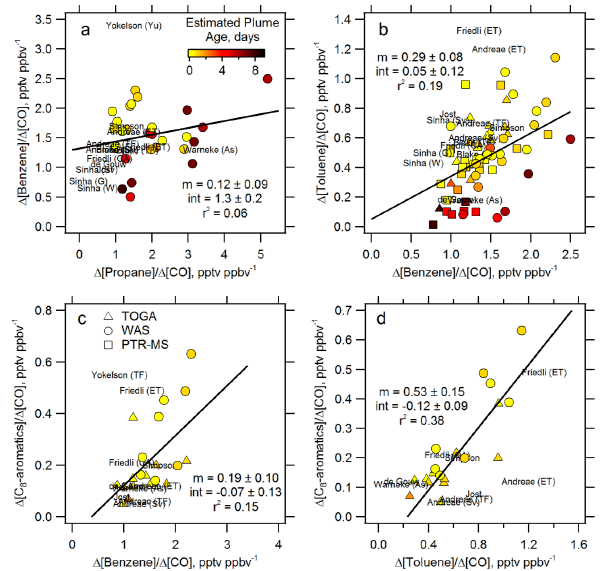
Fig. 9. Similar to Fig. 8, comparison plots of the NEMRs to CO observed during ARCTAS for aromatic hydrocarbons and propane. Comparisons using NEMRs from three instruments are shown, ac- cording to the legend in (c) . Also shown are the corresponding lit- erature NEMR ratios listed in Tables 3 and